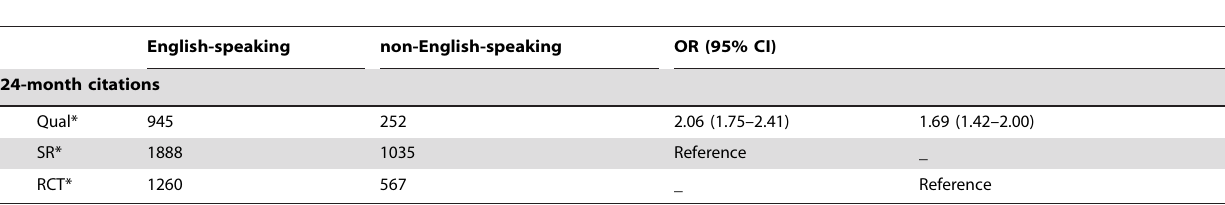
Table 2. Citation frequencies of articles published in English-speaking and non-English-speaking